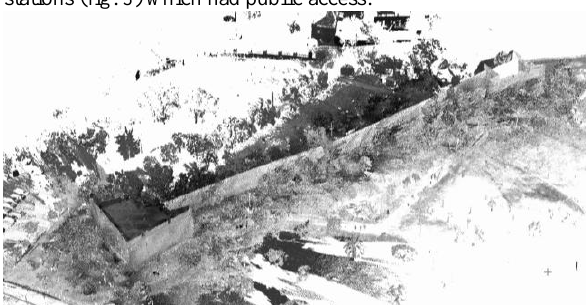
Figure 3. Partial view of the laser scanning survey of “Baluarte das Freiras”